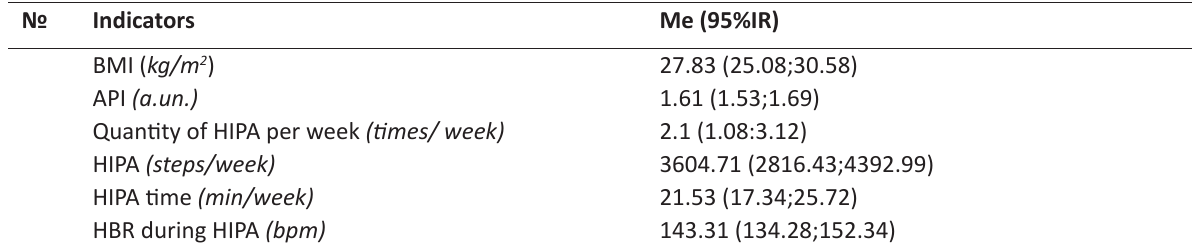
Table 1. Physiological indicators of mature men, who practice healthy life style (n=26)